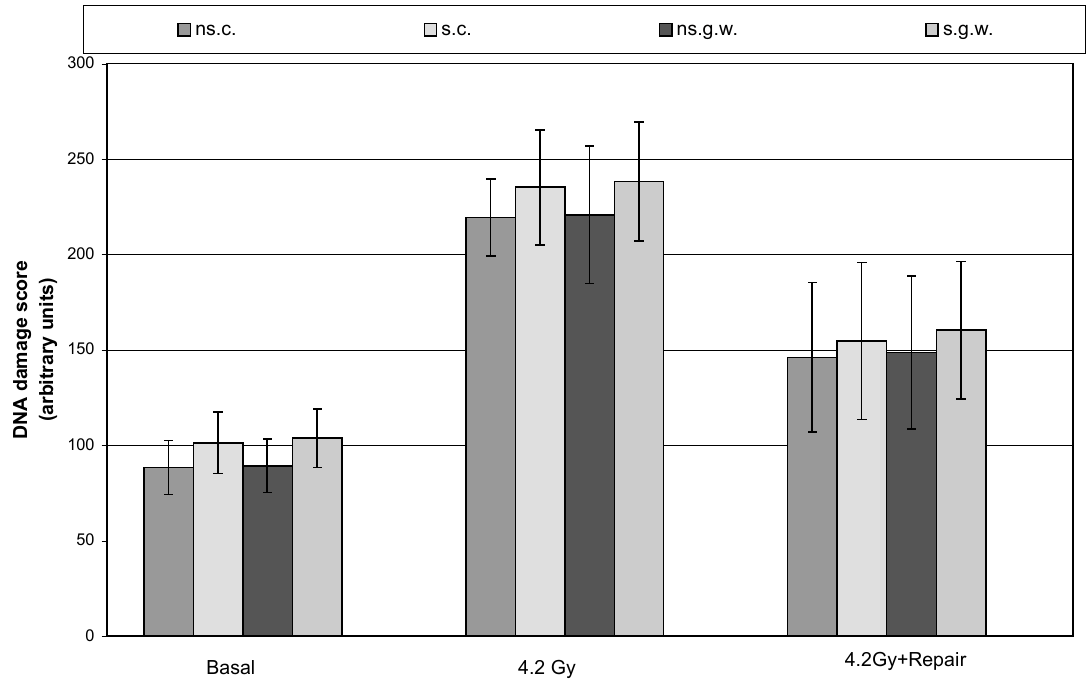
FIGURE 2. Response of lymphocytes of the groups [nonsmokers control (ns.c); smokers control (s.c.); nonsmokers greenhouse workers (ns.g.w.); smokers greenhouse workers (s.g.w.)] after exposure to 4.2 Gy 60 Co and after repair. Error bars represent the standard deviation of the mean among the